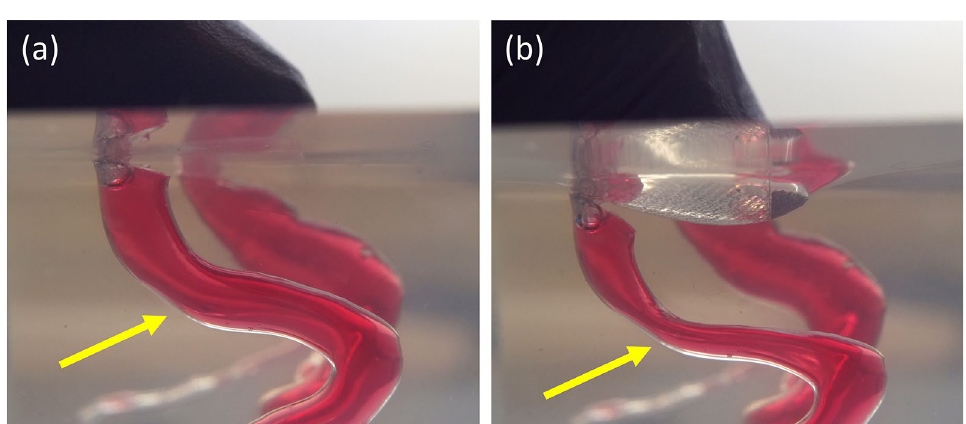
Figure 4. PDMS has a flexible characteristic that can mimic real blood vessels and is therefore used in the phantom model. In panel ( a ) and ( b ), we show the effect on the model before and during the surface is depressed with a thumb, respectively. The channels are filled with a blood like substance (water and food dye) and an external force reduces the size of the channel significantly (as indicated by arrows). Showing possible applications of these compliant phantom models, for example, as to simulate flow restrictions in blood